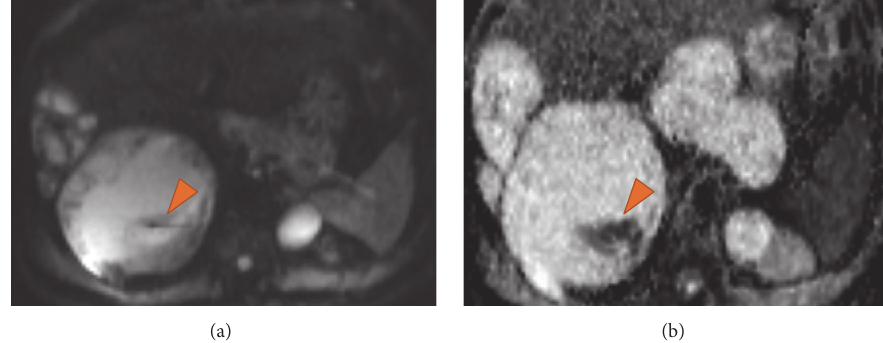
Figure 4: (a) DWI 𝑏 = 50 and (b) ADC mapping at the levels of the liver hydatid cysts and renal cyst show higher signal intensity of the renal cyst at DWI, suggesting a simple cyst. There is also an area of water motion restriction identified as a focus of high signal intensity at DWI and low signal on the ADC map